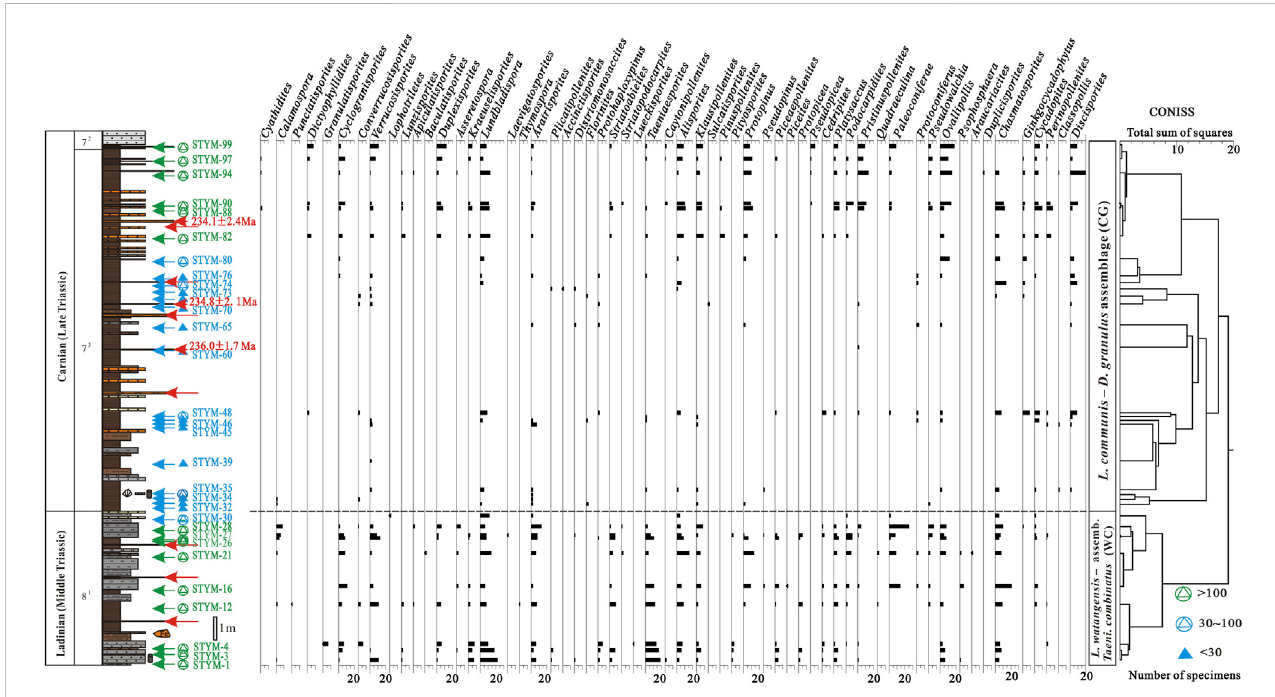
FIGURE 5 Stratigraphy, lithology, productive sample position, and relative sporo-pollen abundances at the Yunmeng pro fi le, Ordos Basin,